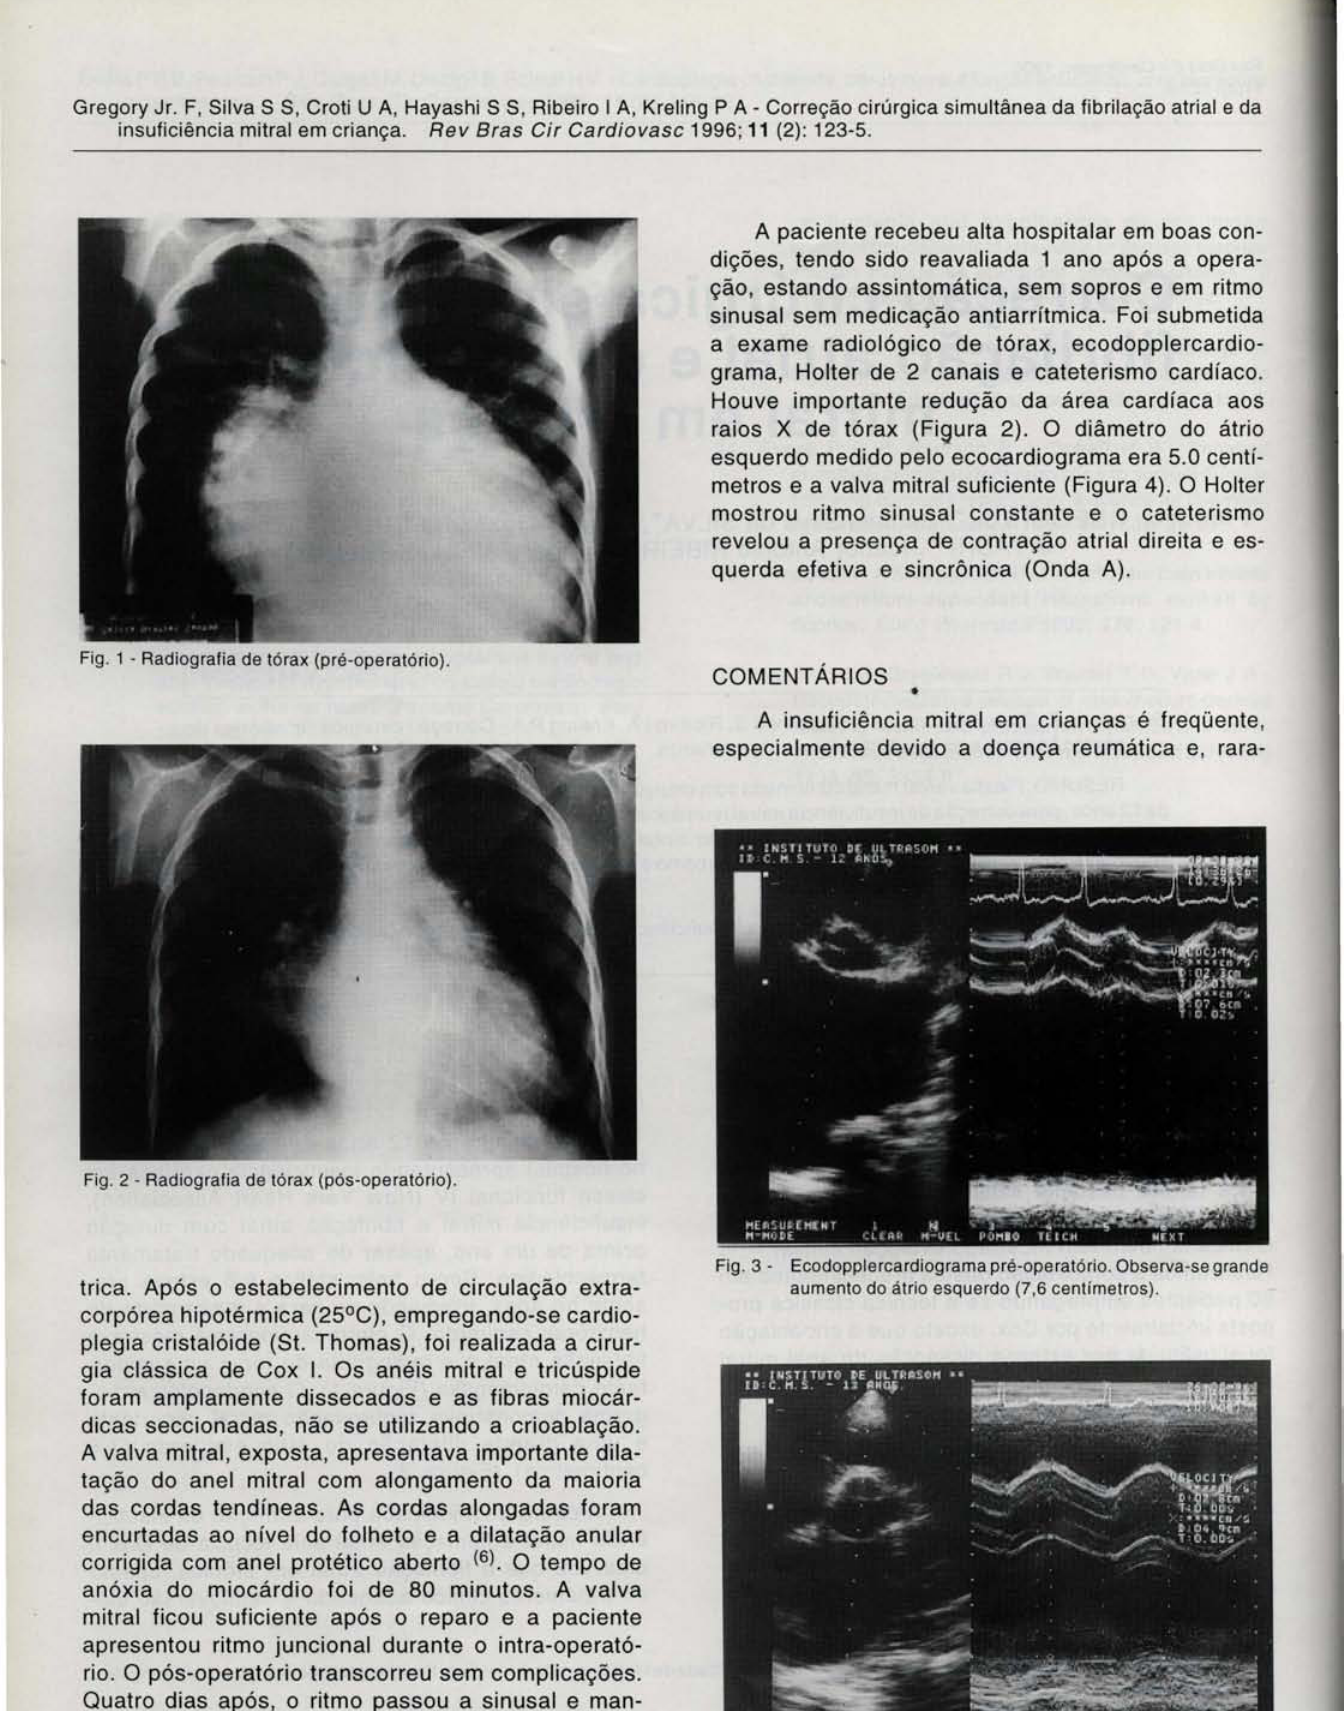
Fig. 4 - Ecodopplercardiograma (pós·operatório). Observa·se dimi· nuição do diãmetro do átrio esquerdo (5,0